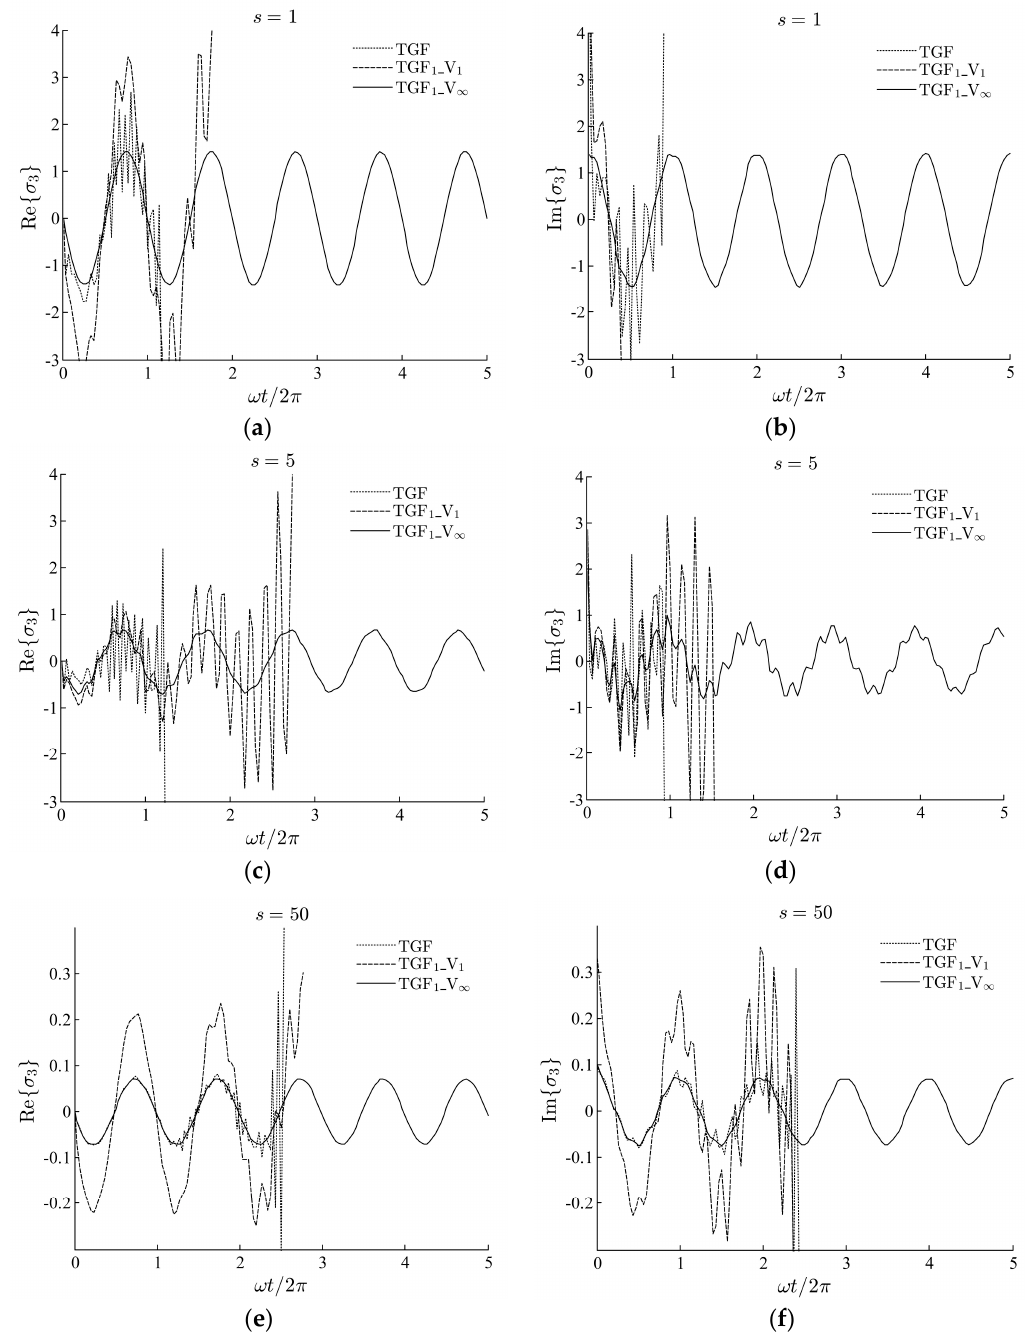
Figure 2. Comparison of time series of source density (real and imaginary part) on segments s = 1,5,50 using methods TGF, TGF 1 _V 1 and TGF 1 _V ∞ . In TGF 1 _V 1 , only the temporal viscous dissipation effects is considered, while in TGF 1 _V ∞ both temporal and spatial viscous dissipation effects are taken into account. In TGF 1 _V n , the reference frequency is set as the heave frequency: ω 0 = 0.8 rad/s, five non-dimensional viscosity coefficient values (cid:101) = 12.5, 10, 7.5, 5.0, 2.5 are respectively imposed onto the field points on the first five segments ( s = 1 ∼ 5 ) on each side of the wetted surface. ( a ) Real part of source density on segment s = 1; ( b ) Imaginary part of source density on segment s = 1; ( c ) Real part of source density on segment s = 5; ( d ) Imaginary part of source density on segment s = 5; ( e ) Real part of source density on segment s = 50; ( f ) Imaginary part of source density on segment s = 50 .